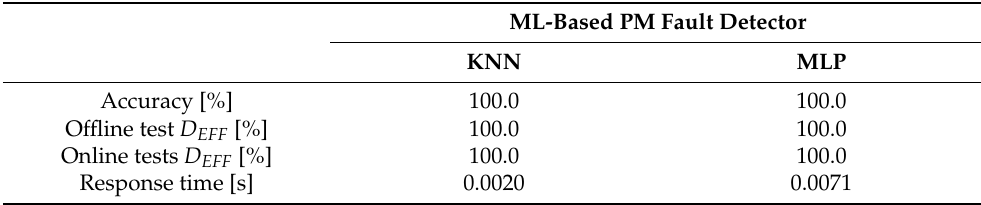
Table 5. The comparison of the analyzed ML-based PM faul detectors details.